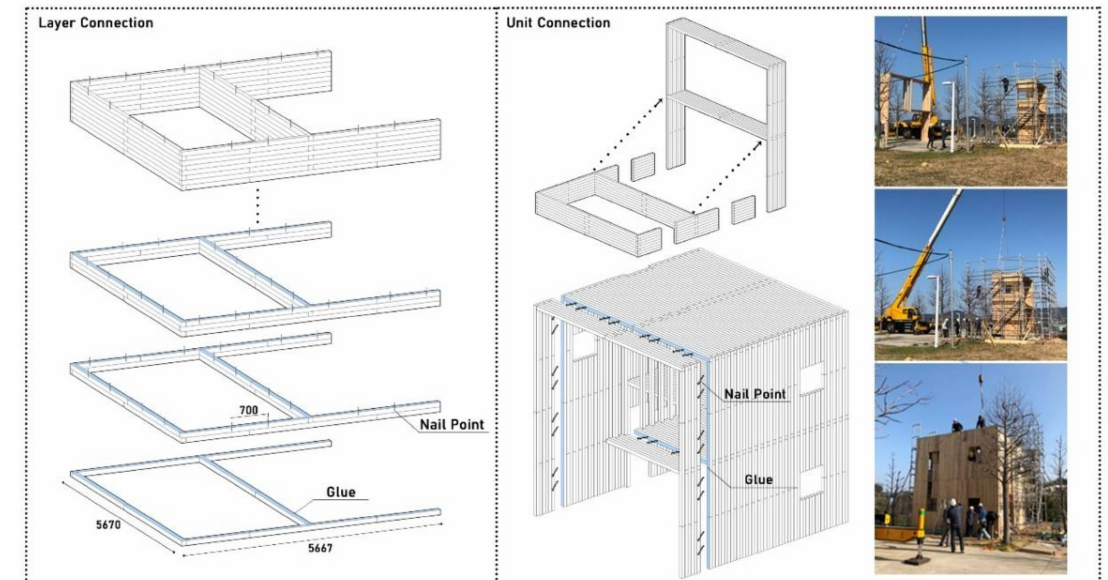
Figure 5. Structure construction of the building.